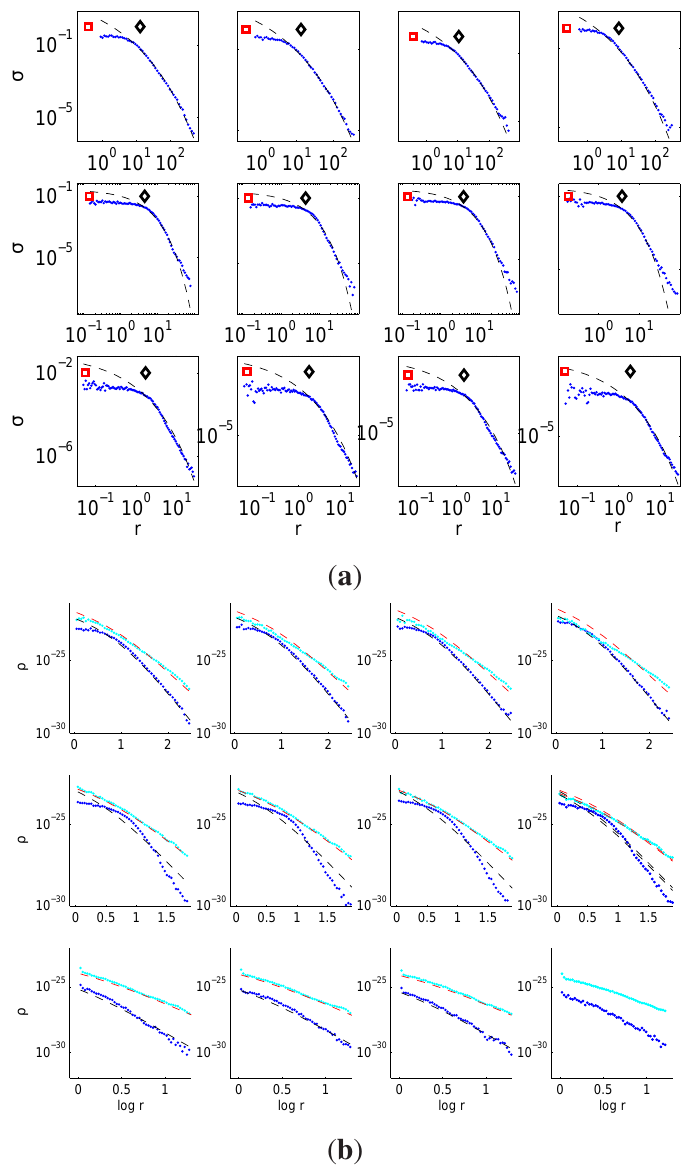
Figure 14. ( a ) Projected surface density σ (g/cm 2 ) against the logarithm of radial distance r ( kpc ) of the stars in the reference models at the last computed age. Blue dots: stellar particles radial averages; dashed line: Sersic best-fit (see text for details). The black diamonds indicate the effective radius R . The red squares show the smallest value reached e by adaptive softening lengths, thus indicating the effective resolution of the simulations; ( b ) Mass densities of stars and DM ρ (g/cm 3 ) against the logarithm of the radial distance (kpc) for the reference models at z 1 . Blue dots: the star particles; cyan dots: the DM ≃ particles; dashed lines: the Hernquist and NFW best-fits. In all rows from left to right: high, intermediate, low, and very low initial density. In each group of three rows from top to bottom: high, intermediate, and low mass galaxies. Reproduced with permission from